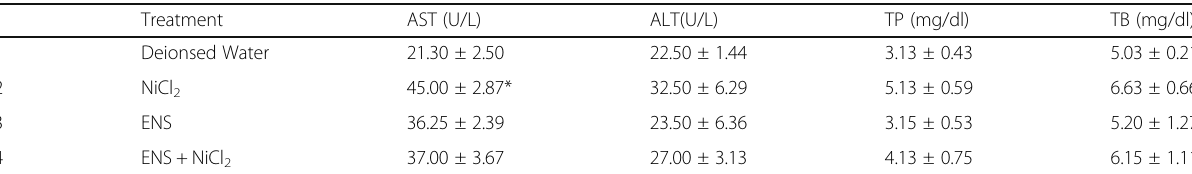
Key: * Significantly different from control KEY